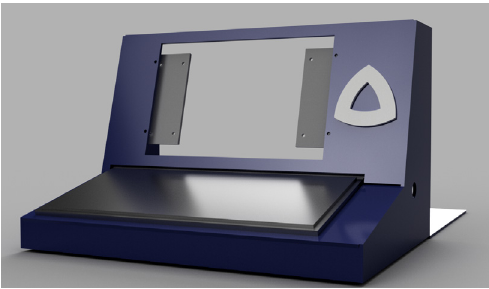
Figure 6. Autodesk Fusion 360 rendering of the handheld unit enclosure. Electronics 2017 , 6 , 9